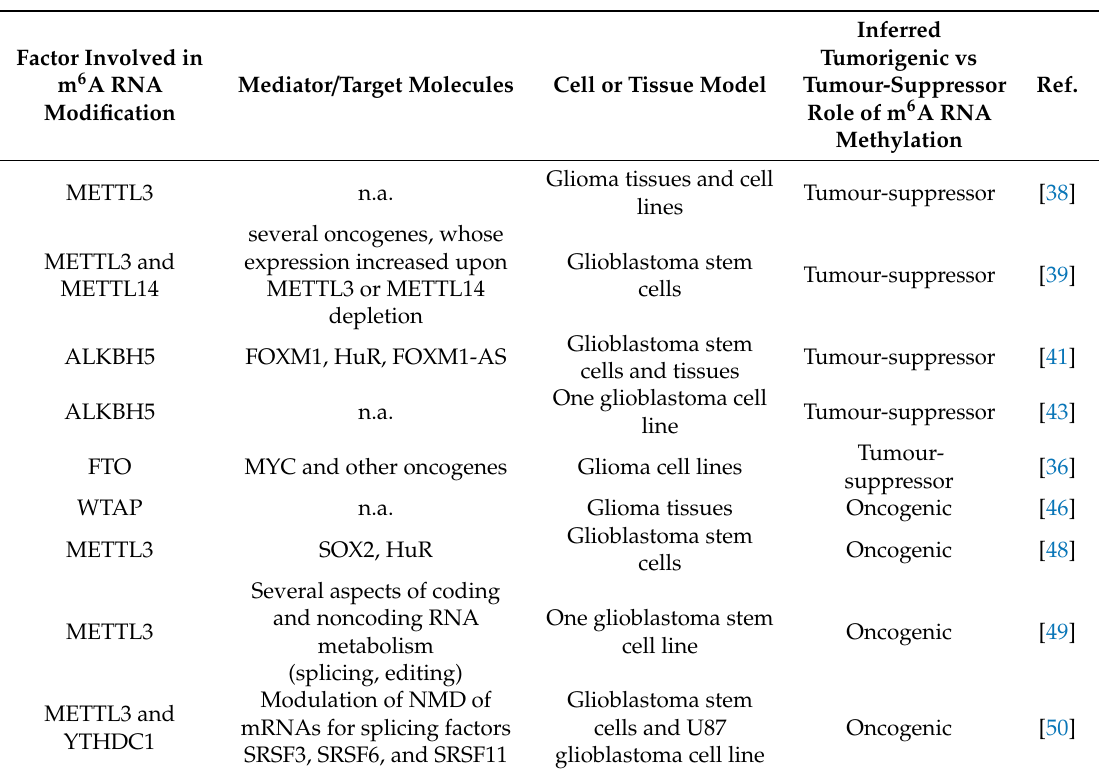
Table 1. Examples of tumour-suppressor vs. oncogenic roles of N 6 -methyladenosine (m 6 A) in glioblastoma, inferred from the study of specific factors involved in m 6 A modulation. NMD: nonsense-mediated decay; n.a.: not